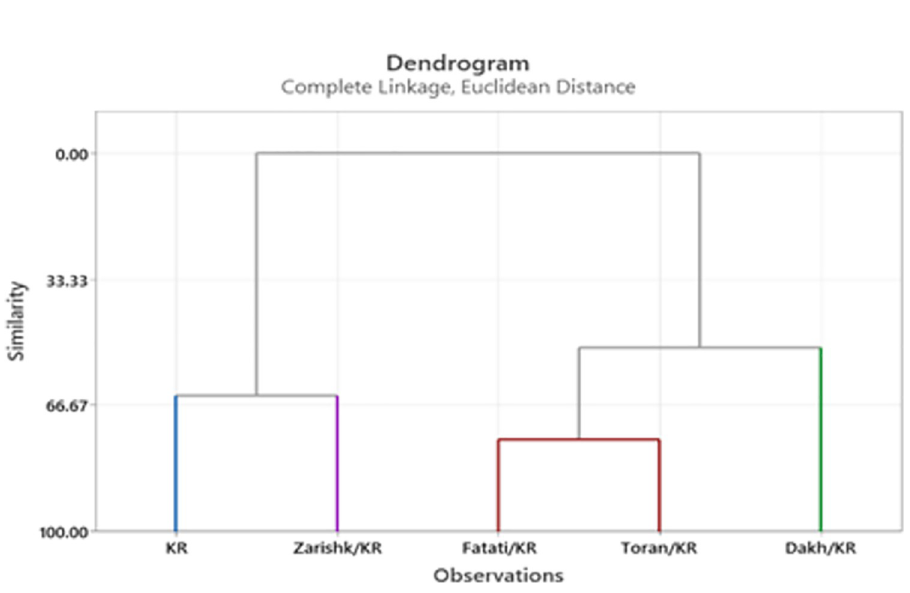
Fig 19. Dendrogram of cluster analysis of un-grafted and grafted Kings Ruby scion variety based on enzymatic and non-enzymatic biochemical traits under -8 bars of drought stress.